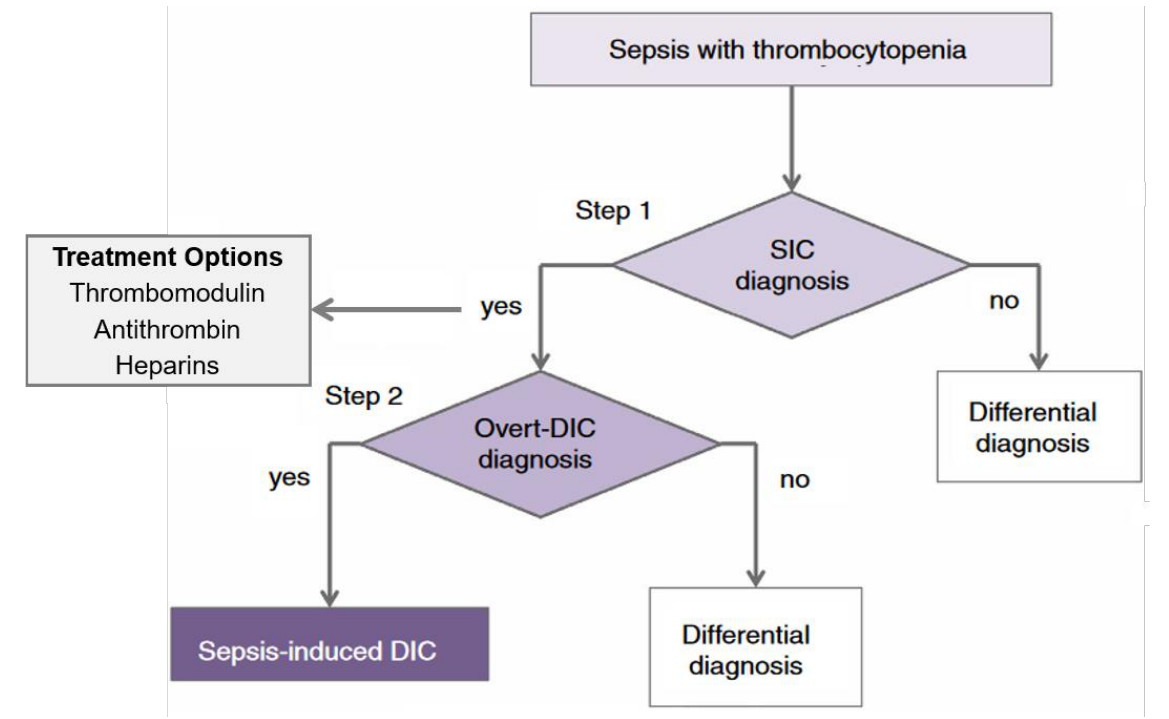
Figure 1. Two-step diagnosis for sepsis-associated DIC. The figure depicts an algorithm to diagnose sepsis-induced coagulopathy (SIC) and overt disseminated intravascular coagulation (DIC). Sepsis patients with thrombocytopenia (platelet count < 150 × 10 9 L −1 ) are screened by using SIC diagnostic criteria (Step 1), and then by using overt DIC diagnostic criteria (Step 2). The rationale for this approach is that SIC and overt DIC represent a continuum wherein the onset of SIC typically precedes that of overt DIC, and where early therapeutic intervention with anticoagulant therapy is most likely to be beneficial. Adapted with permission from Ref. [12]. Copyright ©2019, Blackwell